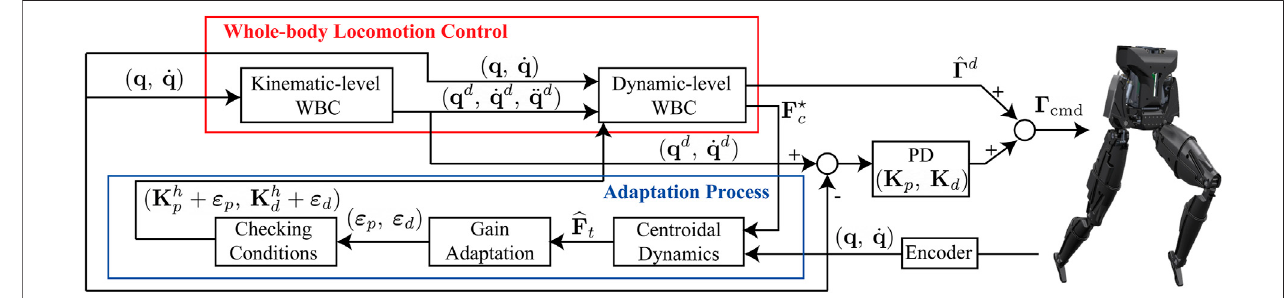
FIGURE 1 | Block diagram of the proposed approach: The proposed approach includes various feedback loops, inside and outside the whole-body locomotion controller (WBLC) Kim et al. (2020). Our adaptive approach is tasked with modifying feedback gains inside